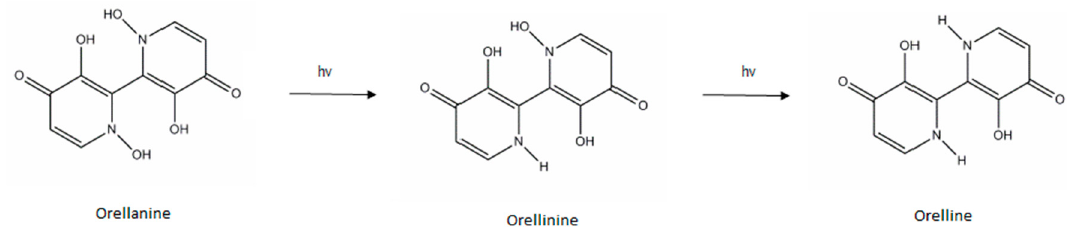
Figure 1. Structure of orellanine and its decomposition products.